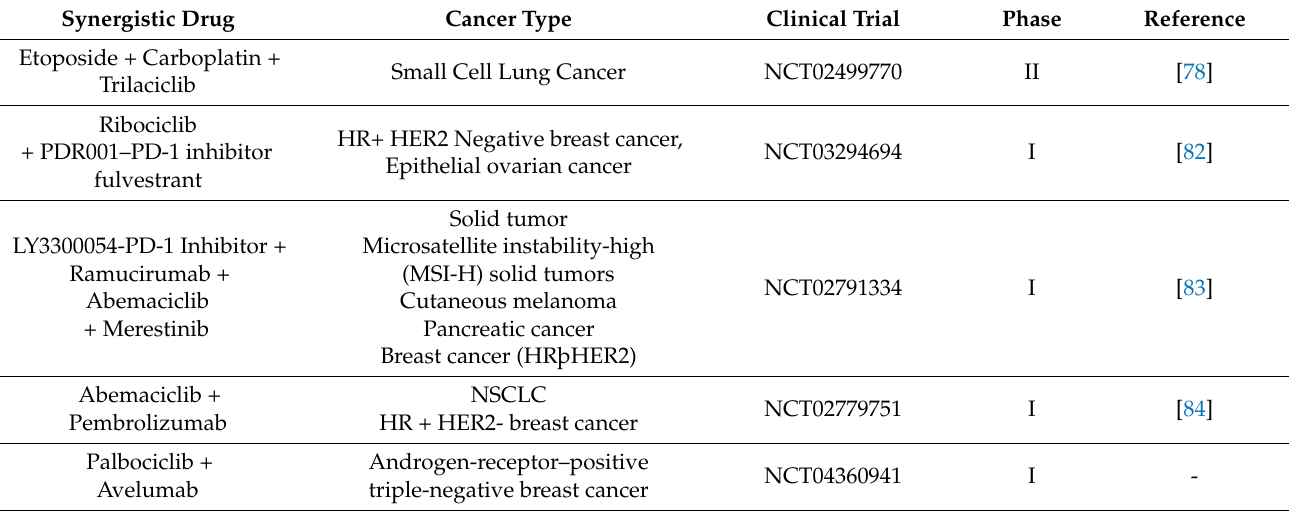
Table 1. List of CDK4/6 inhibitors in combination with immune checkpoint inhibitors/other drugs under consideration or clinically approved in various